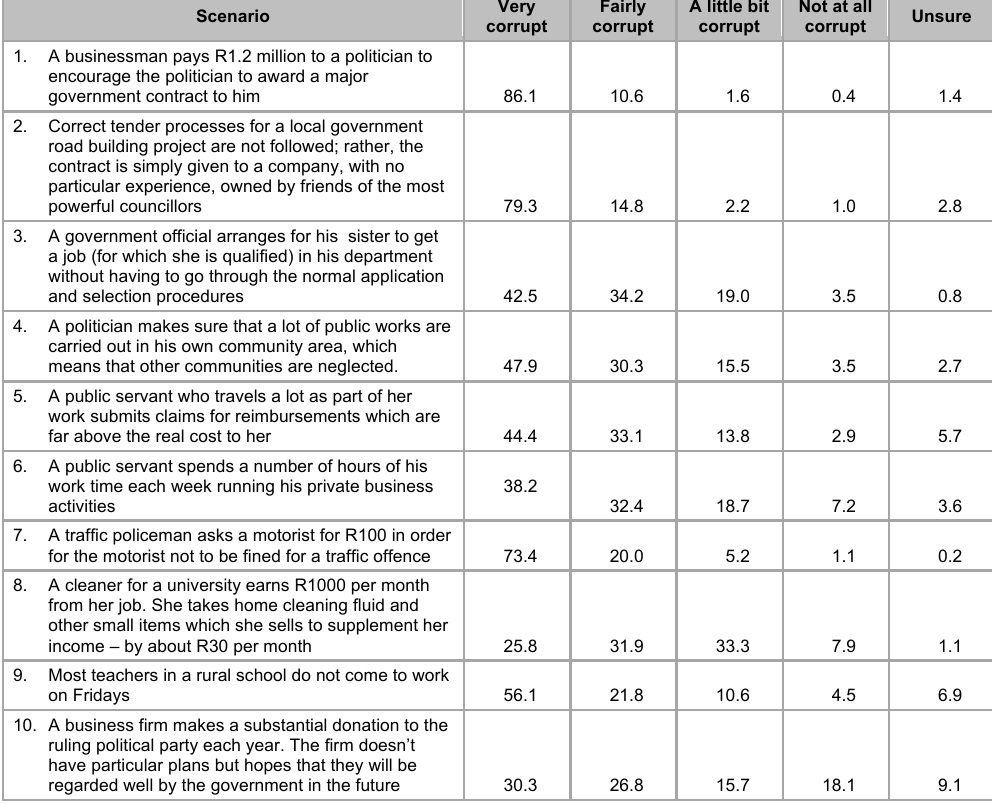
Very Fairly corrupt